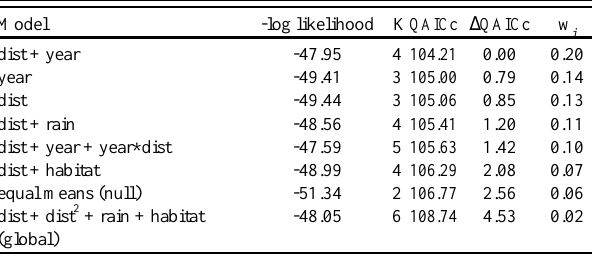
Table 3 . Model selection results for the probability of raptor hatch success in the Lac de Gras study area, 1998 to 2010. Shown are model number of model parameters (K), quasi- Akaike’s Information Criterion score (QAICc) and difference from top model ( D QAICc), and relative model weight (w